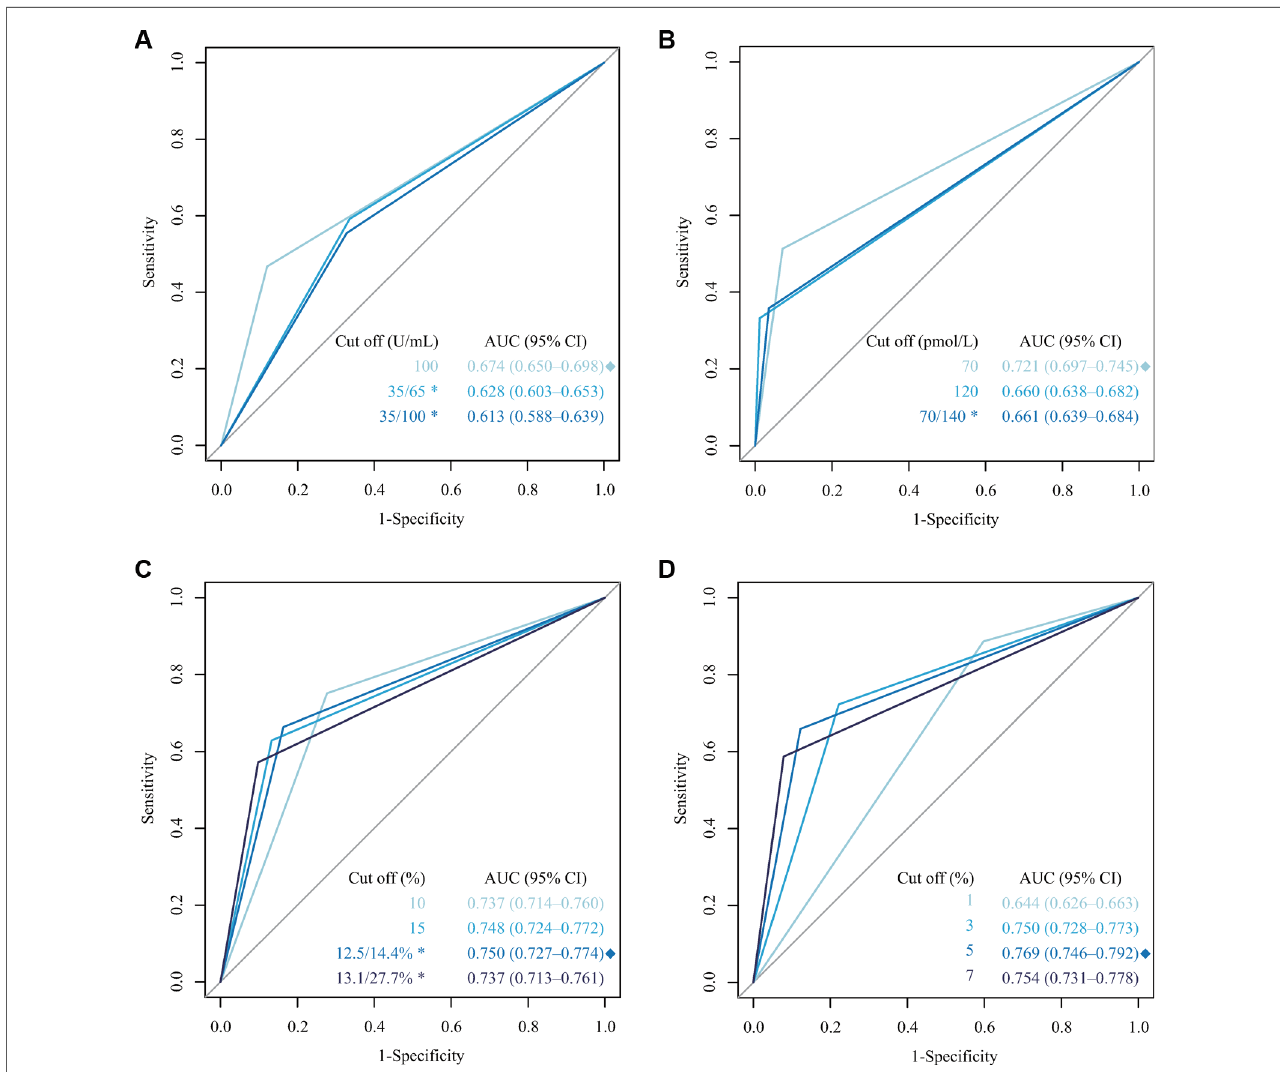
FIGURE 2 Receiver operating characteristic (ROC) curve for different cutoffs of CA125, HE4, ROMA and CPH-I. ( A ) ROC curve of different cutoffs for CA125; ( B ) ROC curve of different cutoffs for HE4; ( C ) ROC curve of different cutoffs for ROMA; ( D ) ROC curve of different cutoffs for CPH-I. *: Premenopausal/postmenopausal women; ◆ : The highest